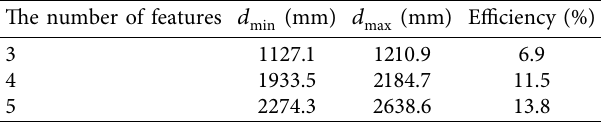
Table 3: Detection